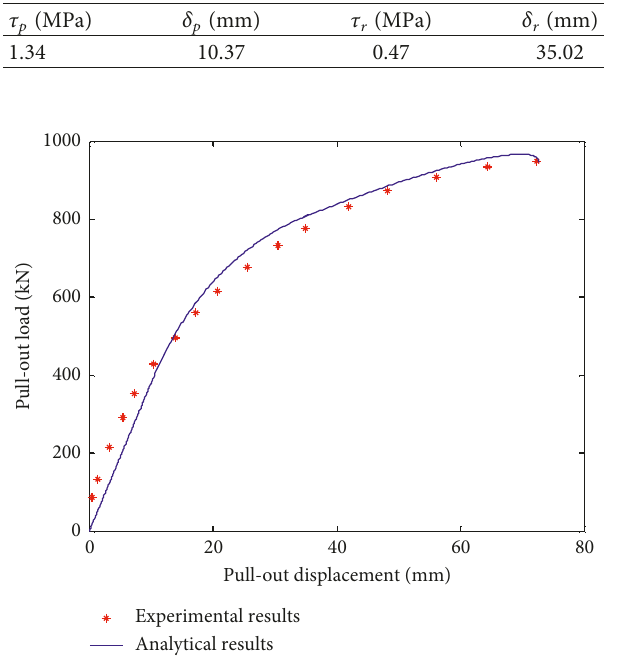
Table 4: Input parameters for the bond-slip model.